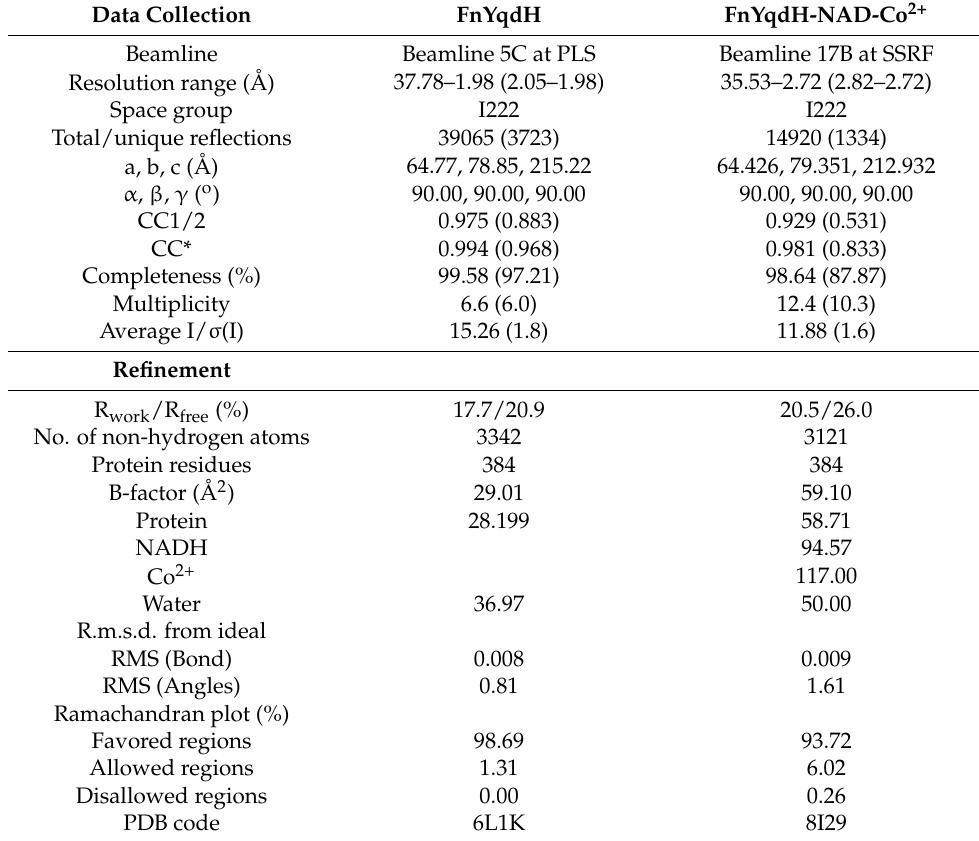
Table 1. Crystallographic data and refinement